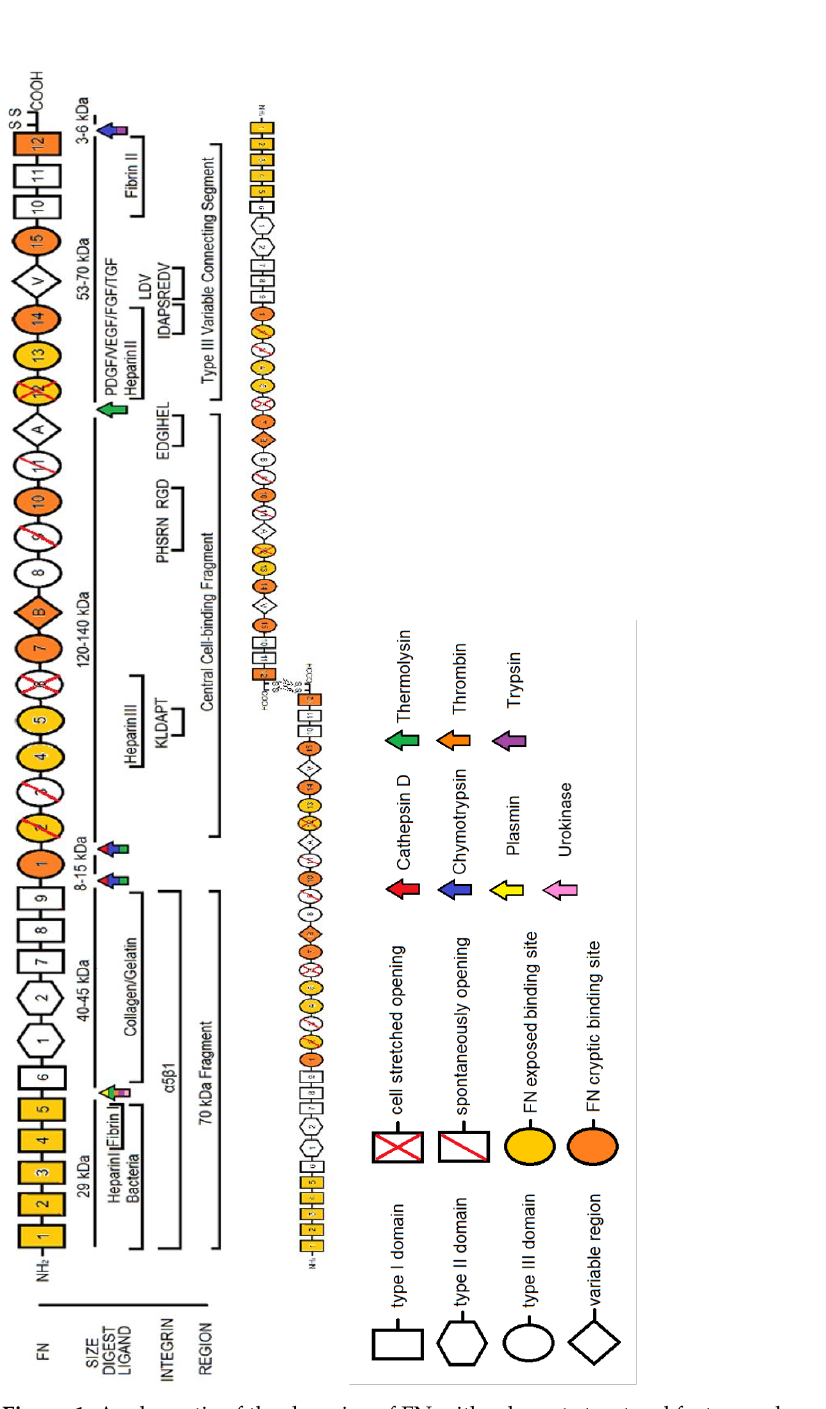
Figure 1. A schematic of the domains of FN with relevant structural features, cleavage sites, nomen- clature, and integrin binding. FN is an approximately 250 kDa protein that is secreted as a dimer. Individual domains are classified as Type I (rectangles), Type II (hexagons), Type III (ovals), or a variable region (diamond). Domains that spontaneously open are shown with a single red slash, while domains that are mechanically unfolded are shown with a red X. Domains that have exposed FN–FN binding sites are shown in gold, while FN domains that have been shown to exhibit cryptic FN–FN binding sites are shown in orange. Molecular weight of regions are directly below. Enzymes known to digest FN are shown at their specific sites with arrows and color coded appropriately. Regions and/or specific sequences that have been shown to bind other ECM constituents are labeled based on size and ligand, then integrins are listed below that, and common terminology for each FN fragment is listed below that. The dimerization of FN at its C-terminus is shown at